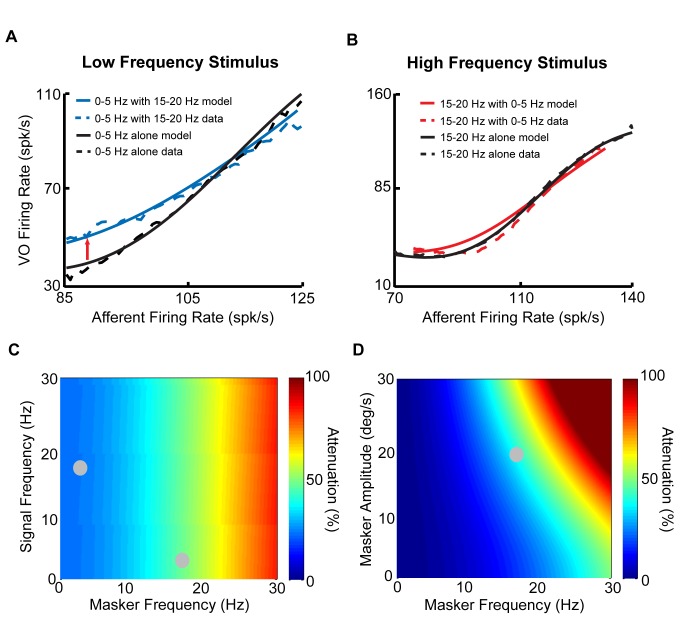
A simple model accurately predicts nonlinear central VO neuron responses to sums of low and high frequency stimuli.(A) Model (solid) and data (dashed) relationships between afferent firing rate and central VO neuron firing rate when the low frequency stimulus was presented alone (blue) and concurrently with the high frequency stimulus (black). Note that the model accurately reproduces the decrease in slope seen experimentally as evidenced by the large overlap between the model and data curves (R
2 = 0.92). (B) Model (solid) and data (dashed) relationships between afferent firing rate and VO neuronal firing rate when the high frequency stimulus was presented alone (red) and concurrently with the low frequency stimulus (black). Note that the model also accurately reproduces the lack of change seen experimentally as the model curves largely overlap with the experimental ones (R
2 = 0.99). (C) % gain attenuation plotted as a function of signal and masker frequency. The stimulus for which the response is computed is referred to as the signal, while the other stimulus is referred to as the masker. Maskers with higher frequency content lead to greater gain attenuation. (D) % gain attenuation as a function of masker amplitude and frequency. Maskers of greater amplitude and frequency lead to greater gain attenuation.